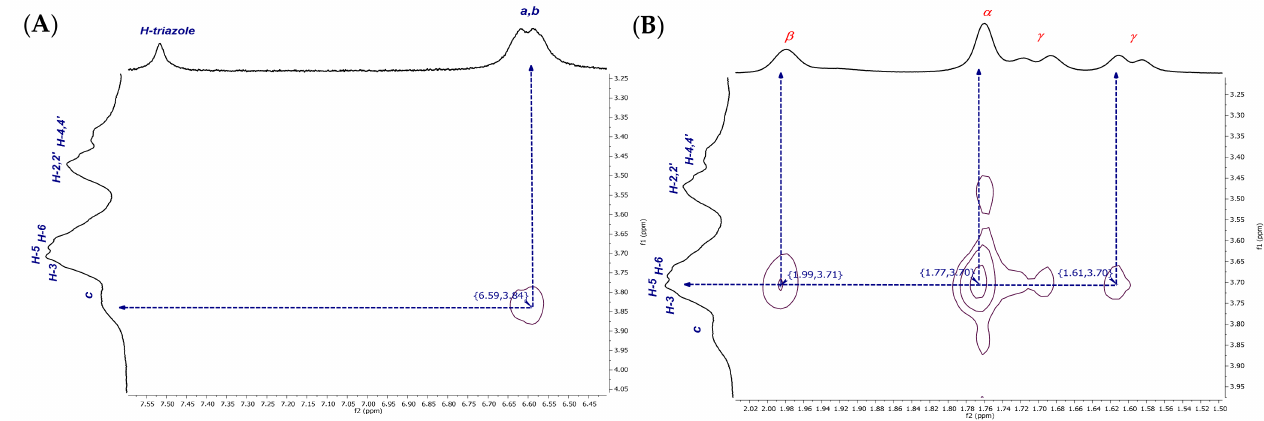
Figure 12. Amplification of ( A ) aromatic and ( B ) aliphatic zones in 2D NMR NOESY spectrum of inclusion complex P 3 N 3 -[O-C 6 H 4 -O-(CH 2 ) 3 - β CD] 6 /AdCOOH in D 2